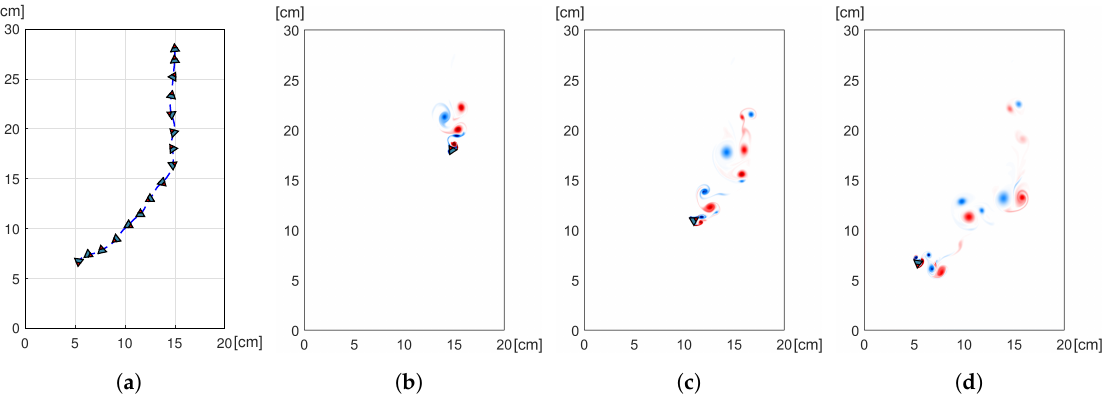
Figure 7. ( a ) Falling trajectory and orientation of a regular triangle. Flow field featured by vorticity contours at time ( b ) t = 1.2 s, ( c ) t = 2.1 s, and ( d ) t = 3